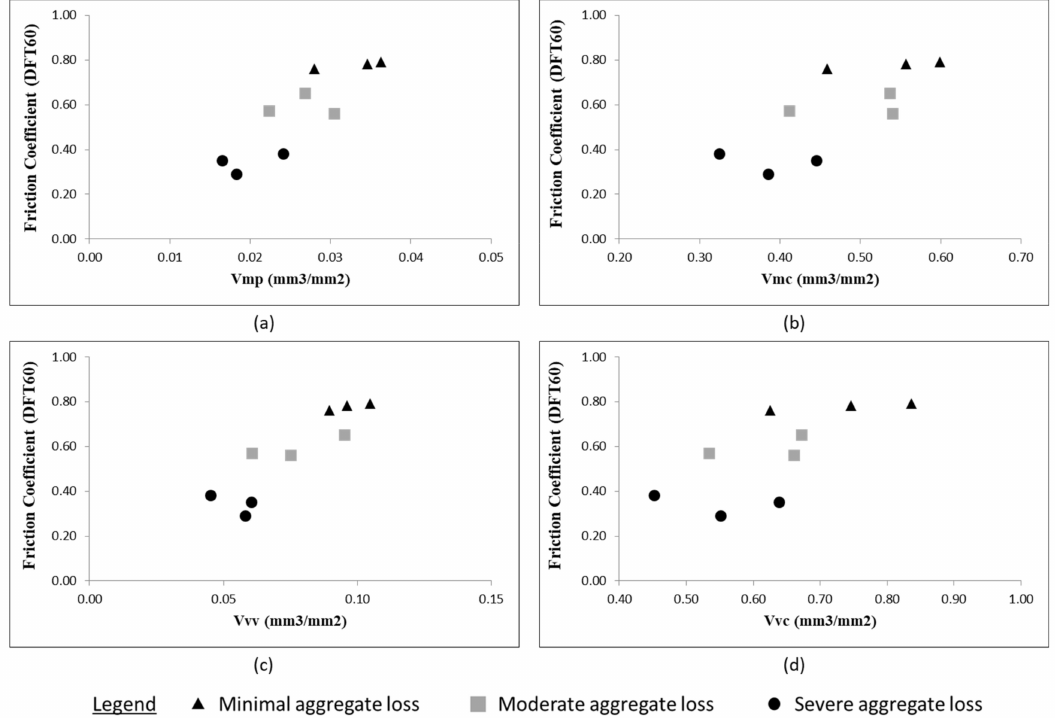
Figure 17. Relationship between DFT60 friction coefficient and volume parameters including ( a ) peak material volume (V mp ), ( b ) core material volume (V mc ), ( c ) valley void volume (V vv ), and ( d ) core void volume (V vc